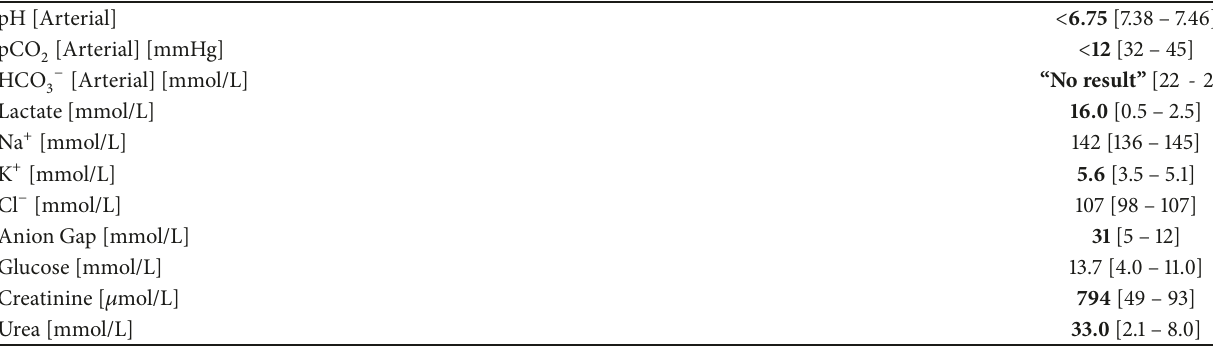
Table 2: Arterial blood gas, serum lactate level, and serum electrolyte